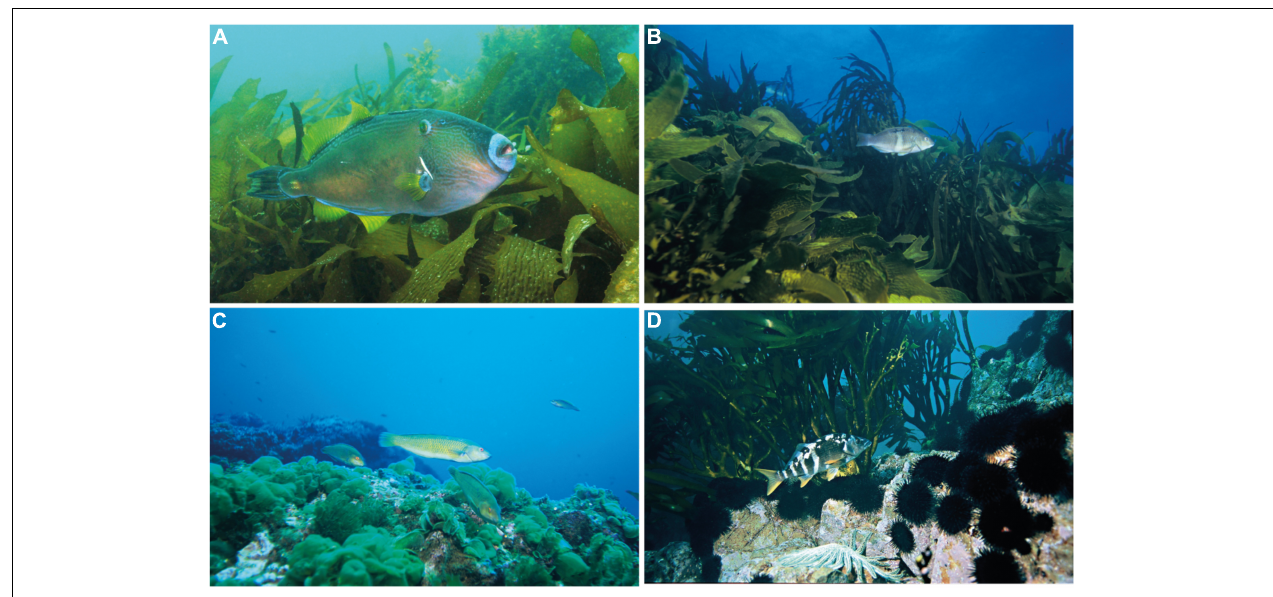
FIGURE 2 | Characteristic fish and habitat-forming macroalgal species from biogeographic provinces surveyed across the temperate South Pacific Ocean: (A) Southeast Australian Shelf (SAS), (B) Northern and Southern New Zealand (NNZ and SNZ), (C) Juan Fernandez and Desventuradas (JFD), and (D) Warm Temperate Western Southeatern Pacific